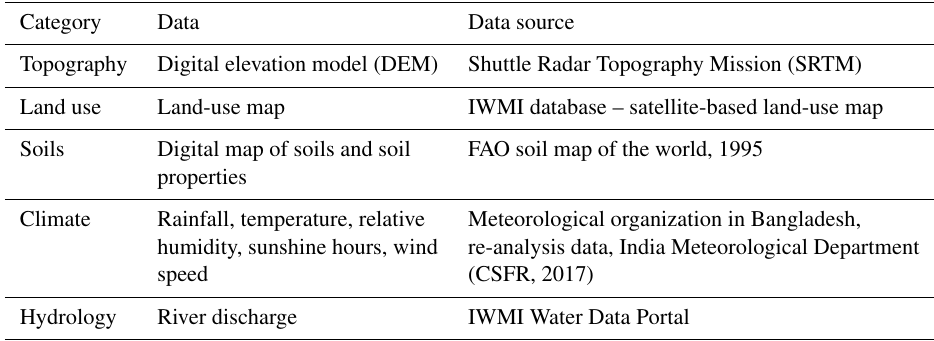
Table 1. An overview of the main data sets used in this